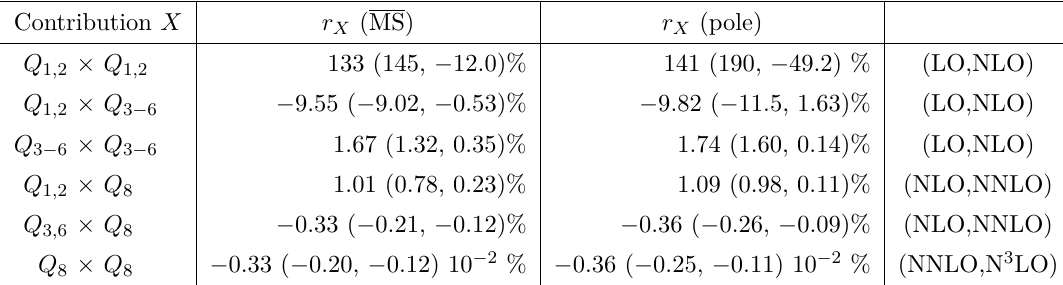
Table 3. Relative contributions in percent in the MS and pole schemes. The breakdown into one- and two-loop contributions is shown inside the round brackets. In the last column we mention the corresponding perturbative